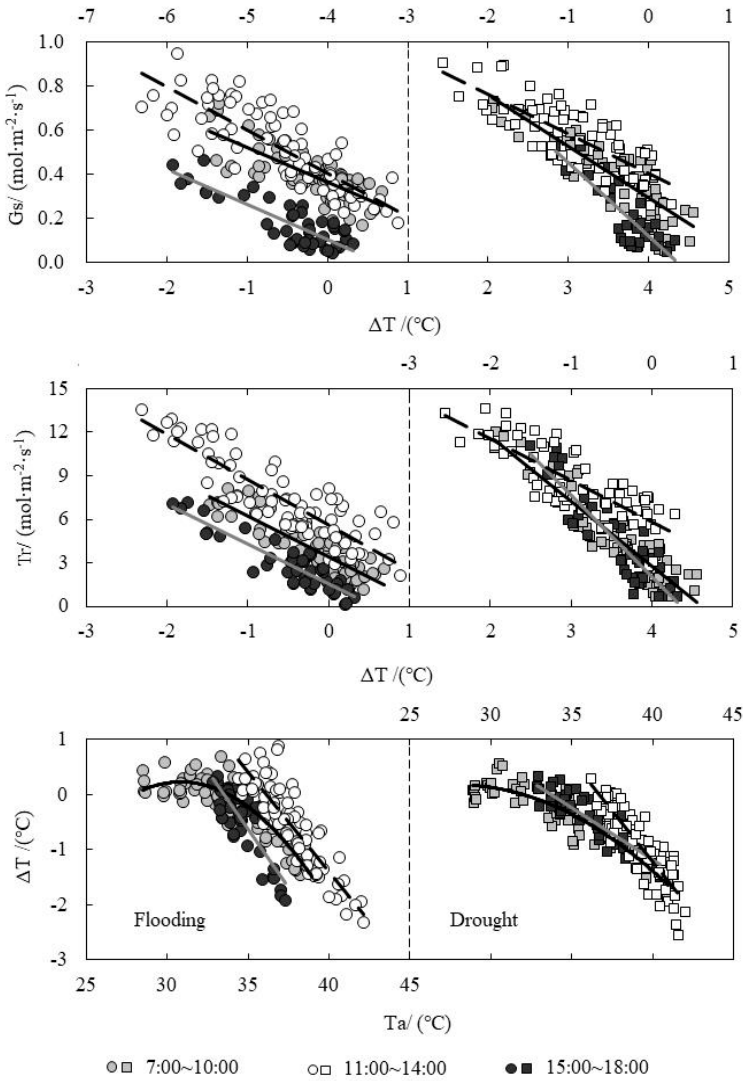
Figure 4. Relationship between temperature difference ( ∆ T) and stomatal conductance (Gs), evapotranspiration rate (Tr), and air temperature (Ta) under water level control.